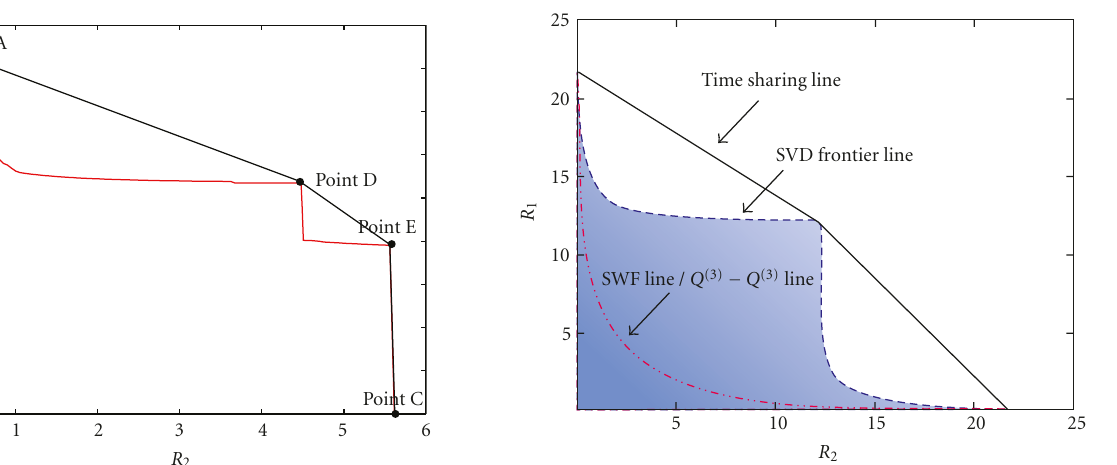
Figure 3: Achievable rate region for the MIMO interference channel—one particular channel realization (user two observes strong interference).